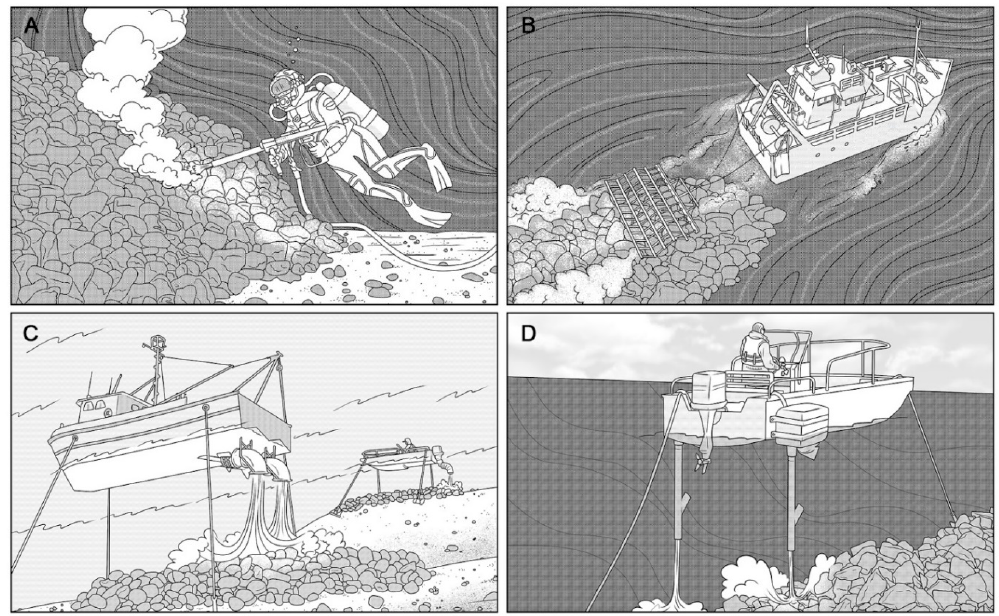
Figure 6. Potential reef cleaning mechanisms, including ( A ) pressure washing by divers using tools for cleaning large vessels, ( B ) removal of mussels or periphyton using a large vessel and a pasture or disc harrow, ( C ) excavation of sediment with a prop wash diverting mailbox system for large vessels (depths up to 15 m) and small vessels (water depths <5 m), ( D ) sediment removal via pumps or engines such as those used by personal watercraft.